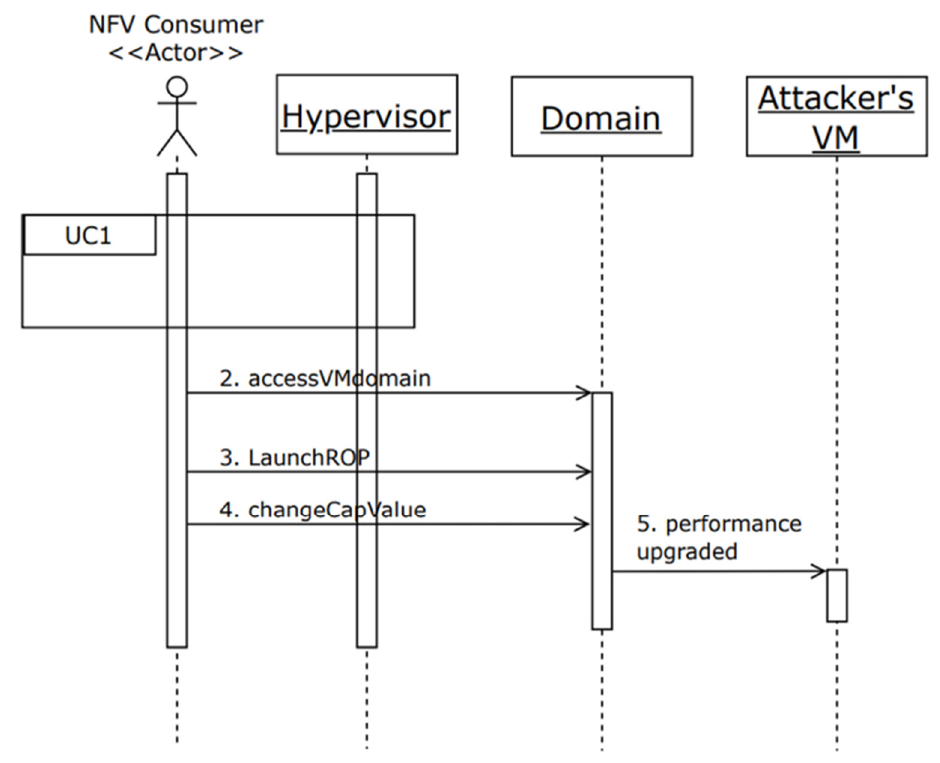
Figure 5. Sequence diagram for use case “Upgrade the performance of the attacker’s network ser-